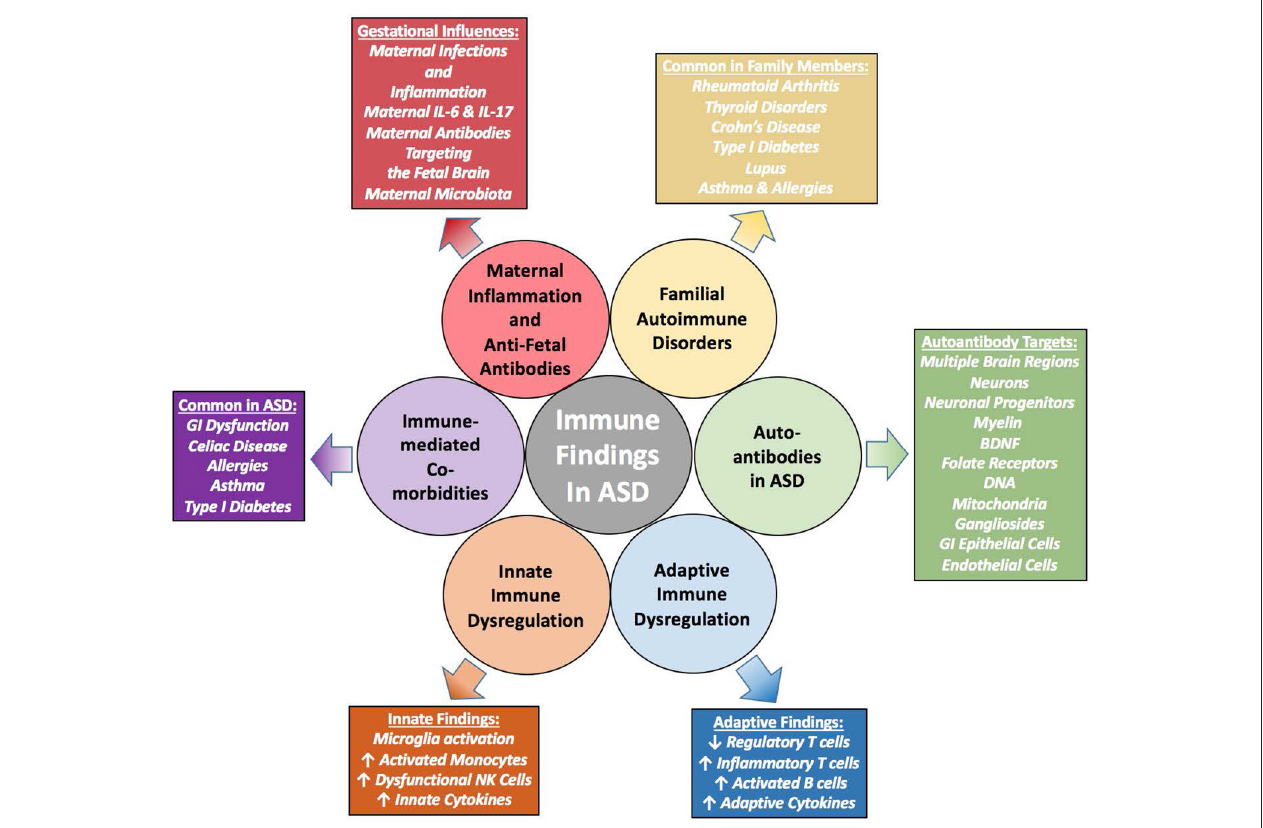
FIGURE 3 | Summary of Immune Evidence in ASD–is Immune Dysregulation Causing or Contributing to these Disorders? Immune findings in individuals with ASD have grown from a few scant early studies to a plethora of extensive and varied research showing immune dysfunction that contributes to worsening behaviors. Familial autoimmunity is a common finding within families affected by ASD. In addition, individuals with ASD have significant immune dysregulation that contribute to altered behaviors. These individuals also suffer more so than the general population from immune-mediated comorbidities such as allergies, asthma and gastrointestinal (GI) disturbances. Mechanistically, studies have shown that the gestational immune environment must be delicately balanced, and without such balance neurodevelopment can be altered. Whether these immune characteristics are causal or just sequelae of the overarching disorders remain to be determined; however, the evidence is building that the dysregulated immune response may be pathologically contributing to